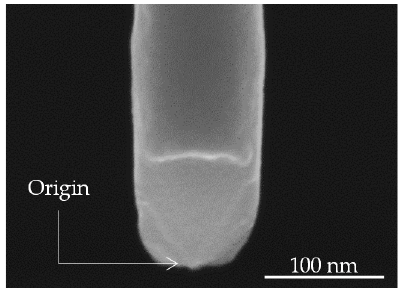
Figure 8. Fracture surface of Specimen A.